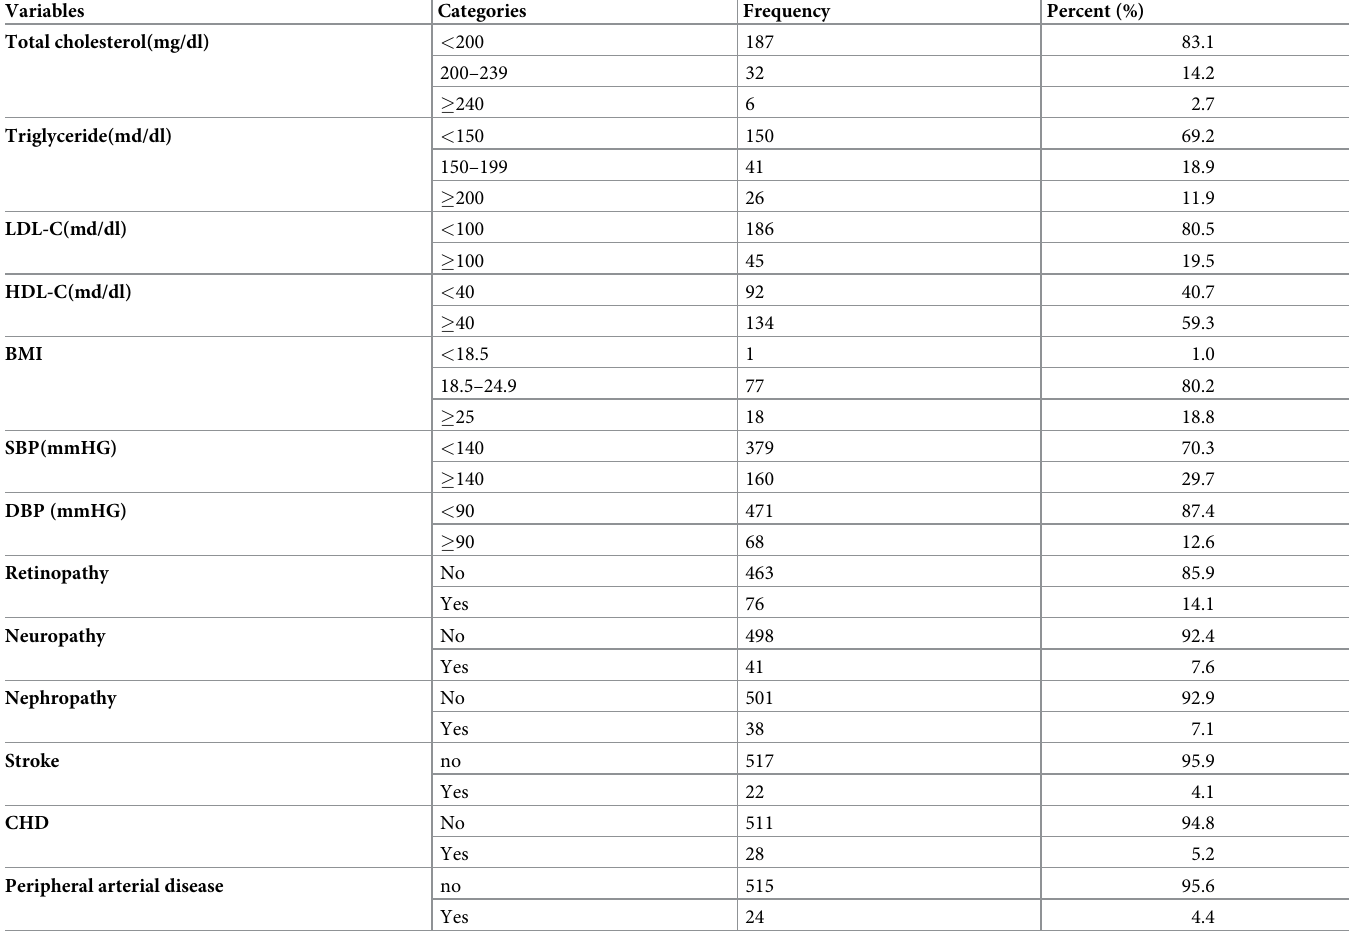
Table 2. Baseline physiologic characteristics and diabetic-related complication among DM patients on treatment at UoGCSH, FHRH, and DTRH in Northwest Ethiopia, 2010 to